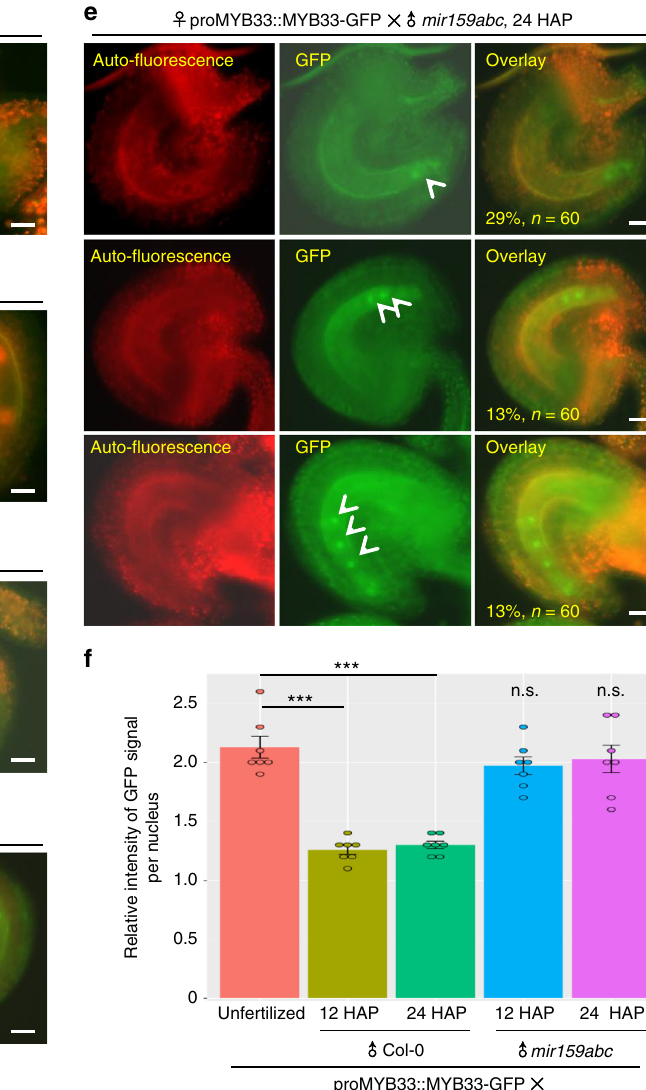
Fig. 3 Subcellular localization of proMYB33::MYB33-GFP in the developing seeds. a , b Fluorescence images of the proMYB33::MYB33-GFP/proFWA::RFP doubly transgenic plants in the unfertilized ovule a and the developing seed at 12 HAP b . White dashed circles indicate the RFP signal, and the white arrowheads indicate the GFP signal. proFWA::RFP was used as the marker for the central cell/endosperm nuclei. Embryo sacs are green or red due to auto- fl uorescence. c – e Fluorescence images of the developing seeds from the proMYB33::MYB33-GFP transgenic plants pollinated with pollen of Col-0 at 24 h c , mir159abc at 12 HAP d and 24 HAP e , respectively. All the left panels show the auto- fl uorescence control of the developing seeds under the RFP channel, and the overlay was performed for each. White arrowheads indicate the GFP signal. % indicates the ratio of those developing seeds similar to the representative image relative to total ones. n represents total numbers of analyzed embryo sacs. Scale bar, 20 µ m. f Quanti fi cation of proMYB33::MYB33- GFP signals from a – e . “ unfertilized ” indicates mature ovules of the proMYB33::MYB33-GFP transgenic plants as shown in the middle panel from a . Other columns represent that proMYB33::MYB33-GFP transgenic plants were pollinated as indicated time (12 and 24 HAP) by pollen of Col-0 or mir159abc , respectively. An arrow fl anking each endosperm nucleus was used for the quanti fi cation of GFP signal intensity as shown in Supplementary Fig. 3d, and the measurements were performed using the Image-Pro Insight software. The GFP signal intensity was calculated by the number measured from the endosperm nucleus relative to the average number of fl anking regions along the arrow. One small circle indicates the result from one image. Error bars show SD calculated from ~10 developing seeds for each category, and asterisks indicate a signi fi cant difference between the indicated samples ( t -tests, P - value <0.05). n.s. indicates non-signi fi (Supplementary Fig. 3d) were quickly attenuated after fertiliza- signals of MYB33-GFP (Fig. 3f) or MYB65-RFP (Supplementary tion, as early as the fi rst or second division of the central cell. As Fig. 3d) in the developing endosperm nuclei further con fi rm that endopsperm nuclear divisions proceeds, MYB33 becomes barely the rapid removal of MYB33 and MYB65 after fertilization is detected in the developing seed (Fig. 3c). In contrast, signals of controlled by paternal miR159. MYB33-GFP (Fig. 3d, e) and MYB65-RFP (Supplementary Fig. 3d) in the undivided central cell and/or dividing endosperm Paternal miR159 cleaves maternal MYB33 in the seeds . To nuclei are consistently visible after fertilization when mir159abc conclusively demonstrate the rapid removal of MYB33 and MYB65 was the pollen donor. Quantitative analyses of fl uorescence after fertilization is regulated by paternal miR159, we then